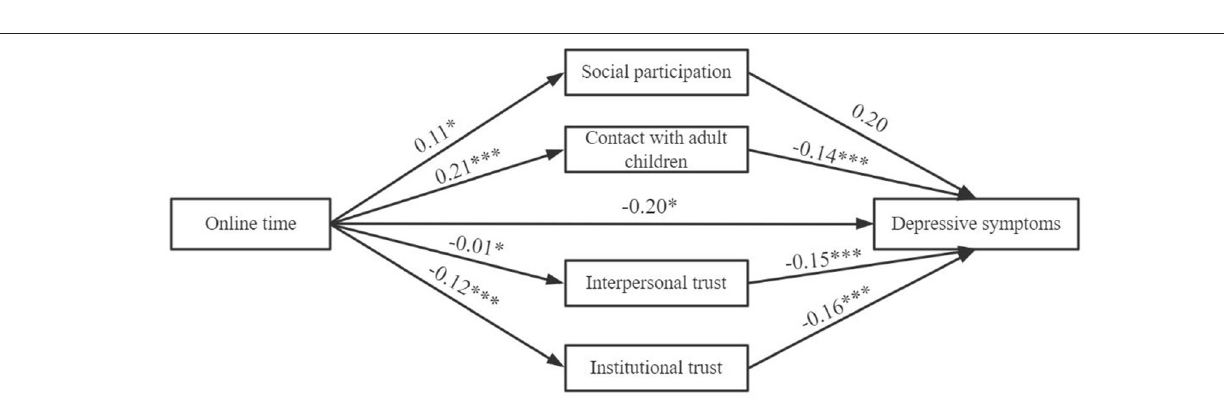
FIGURE 5 | The structural model of the effect of online time on depressive symptoms. * p < 0.05, *** p < 0.001. The confounding variables had been strictly controlled. LL = − 46,583.98, DF = 26, AIC = 47,458.7, BIC = 43,705.2.